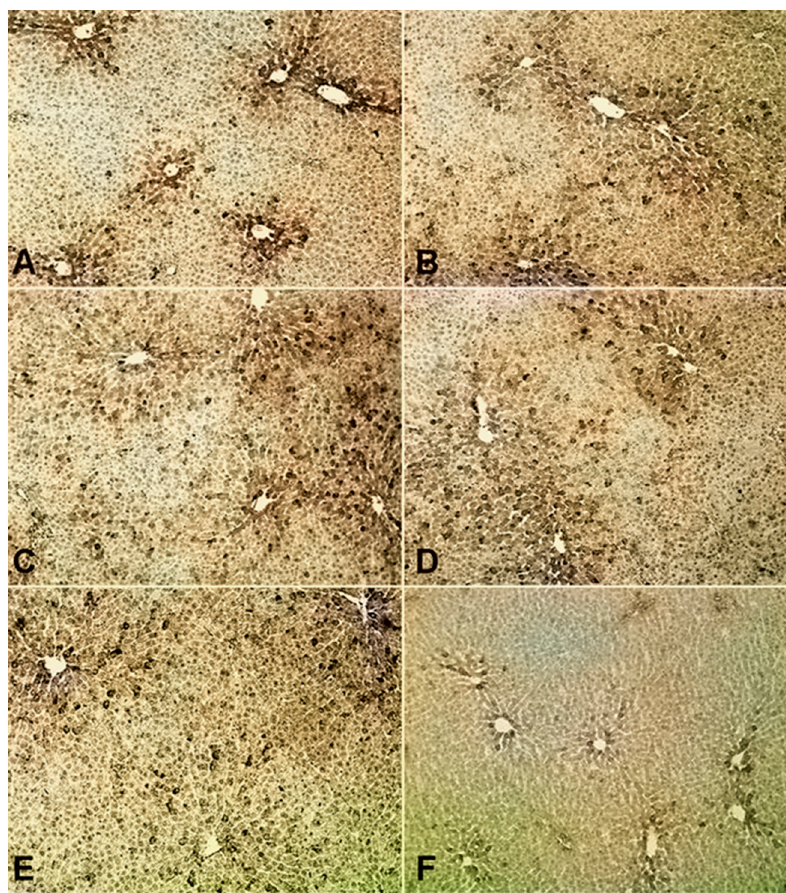
Figure 5. Representative images of liver sections obtained from sham-operated animals treated with vehicle ( A ), melatonin ( B ) or ramelteon ( C ), as well from animals that underwent hemorrhagic shock and treatment with vehicle ( D ), melatonin ( E ) or ramelteon ( F ). Melatonin receptors type 1 were located in a dense composition in pericentral areas of liver lobules in vehicle treated animals; this pattern was replaced by a diminished receptor expression around the central vein after hemorrhagic shock and / or treatment with melatonin or ramelteon. Hematoxylin-stained; magnification 100×.